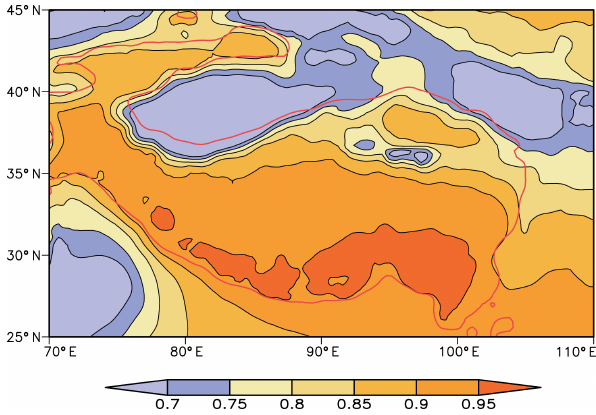
Figure 14. Predicted SSA in summer (CON